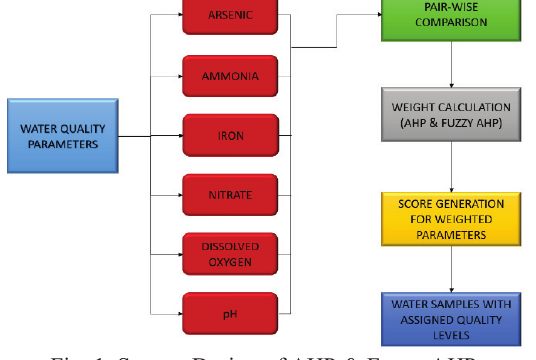
Fig. 1. System Design of AHP & Fuzzy